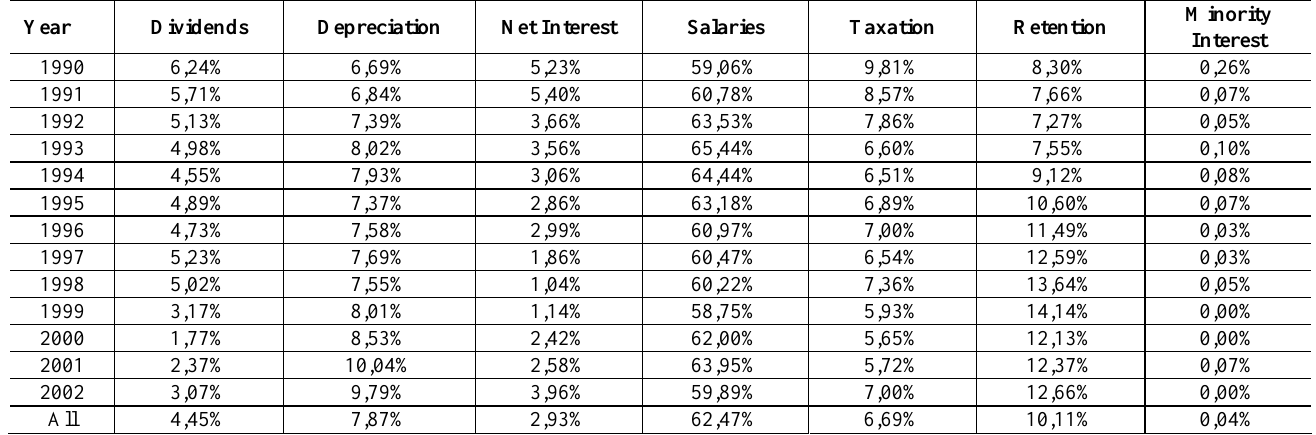
Table 4: Median values of VA distribution ratios 1990 to 2002 – full